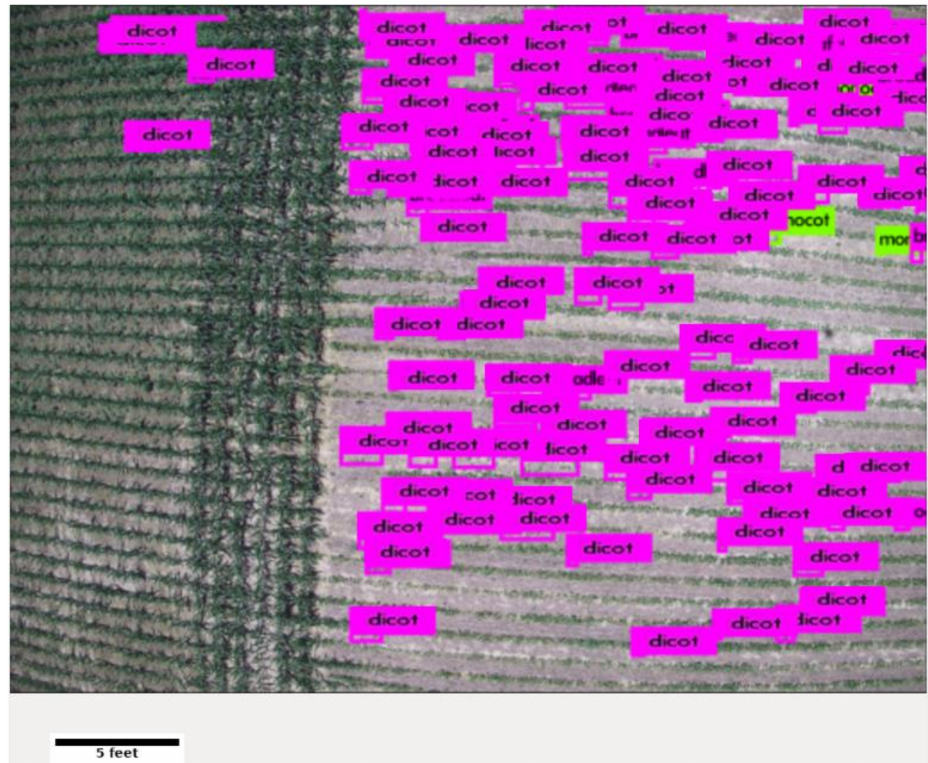
Figure 7. Monocot and dicot detection results from the YOLOv3 network training on Image Set 1. Initial image collection at 30 m AGL caused difficulty in object labeling and contributed to poor network training performance. The mean average precision (mAP) and loss scores over each training iteration are shown in Figure 8 below.